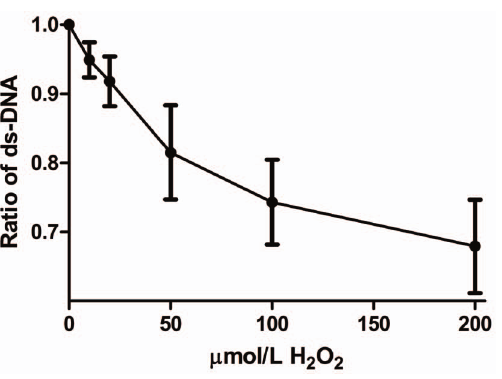
Figure 1. Dose response curve of the effect of H 2 O 2 on ds DNA. Effect of 10, 20, 50, 100 and 200 m mol/L H 2 O 2 on PBMC was tested: 100 and 200 m mol/L reduced %ds DNA significantly (p , 0.02, p , 0.01, respectively).